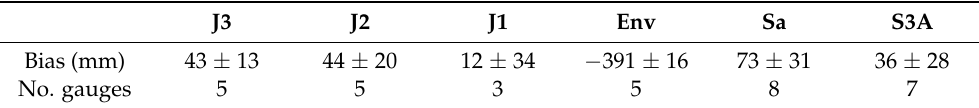
Table 4. Absolute regional mission biases for each mission and number of contributing gauges